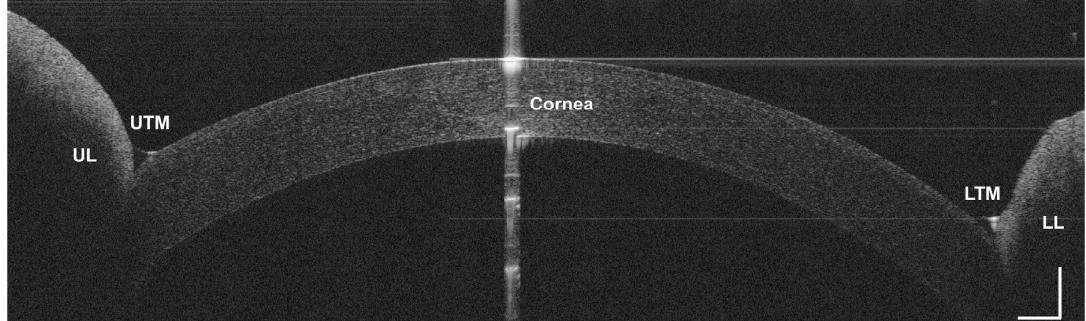
Figure 4. Analysis of tear meniscus as a cross-sectional image (LTM, lower tear meniscus; UTM, upper tear meniscus; LL, lower lid; UL, upper lid). Adapted from Tao et al.